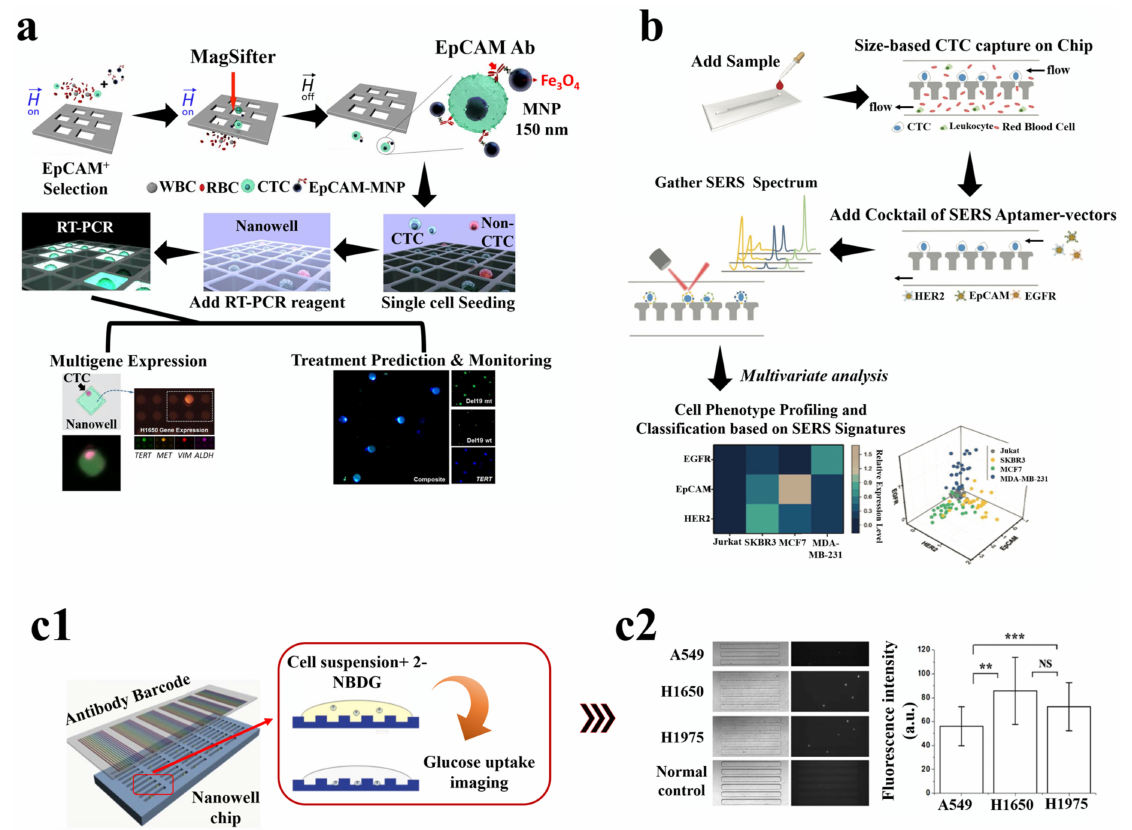
Figure 7. Nanomaterial-based strategies for analysis of CTCs. ( a ) shows the schematic workflow of the nanoplatform for molecular profiling of CTCs. First, the whole-blood samples are processed to isolate CTCs by the MagSifter, and biotinylated anti-EpCAM antibodies are conducted to strepta- vidinated 150 nm iron oxide MNPs. Followed by which the cells are loaded into nanowell device, seeded into individual compartments and mixed with RT-PCR reagent. Then the device is placed into a thermocycler for multigene expression and transcriptome analysis as well as for predicting the efficacy of cancer treatment. Reprinted with permission from [203]. Copyright 2016 Proceed- ings of the National Academy of Sciences of the United States of America. ( b ) demonstrates the workflow of SERS nanovectors for cell-membrane protein profiling to discriminate among the can- cer cell populations. Reprinted with permission from [204]. Copyright 2018 John Wiley and